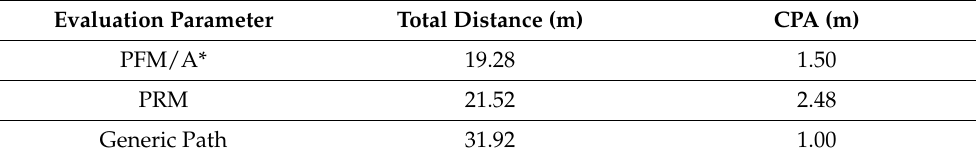
Figure 15. PFM/A* generated path ( left ), PRM generated path ( right ). Table 7. Summary of simulated performance values for Case Study